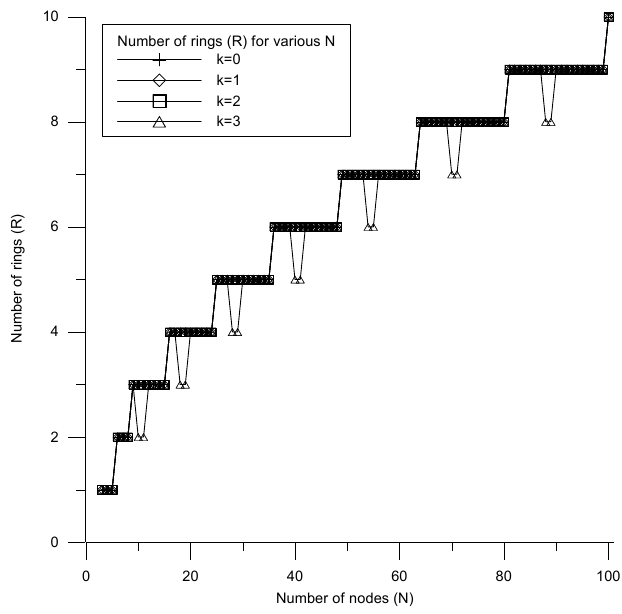
Figure 5. Optimal number of rings for various N .